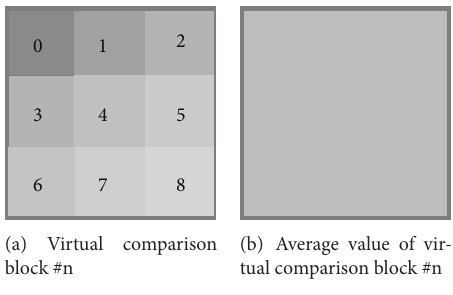
Figure 3: Virtual comparison block and clustering